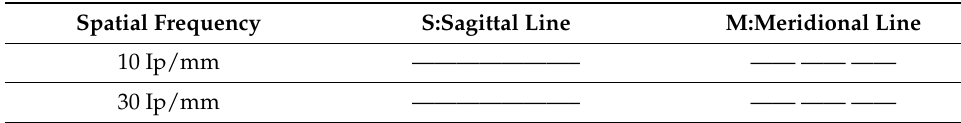
Table 3. MTF chart